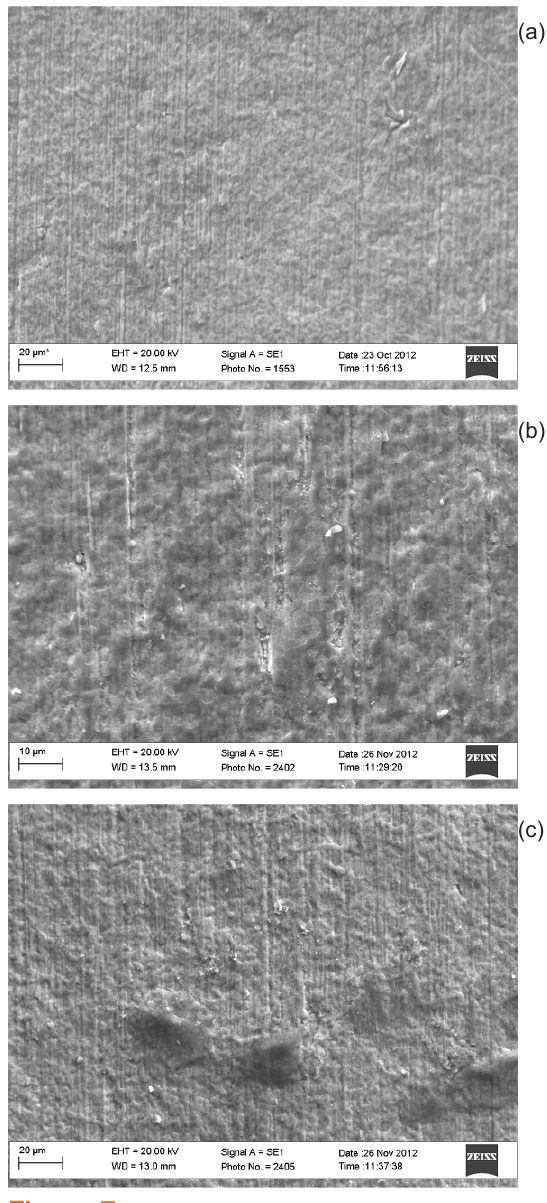
Figure 7. Surface morphology of Ti-6Al-4V alloy after nitriding (a); low-temperature oxidation (b) and high-temperature oxidation (c) of nitride coating based on TiN phase resulting from potentiodynamic polarization in 0.9% NaCl at 40 o